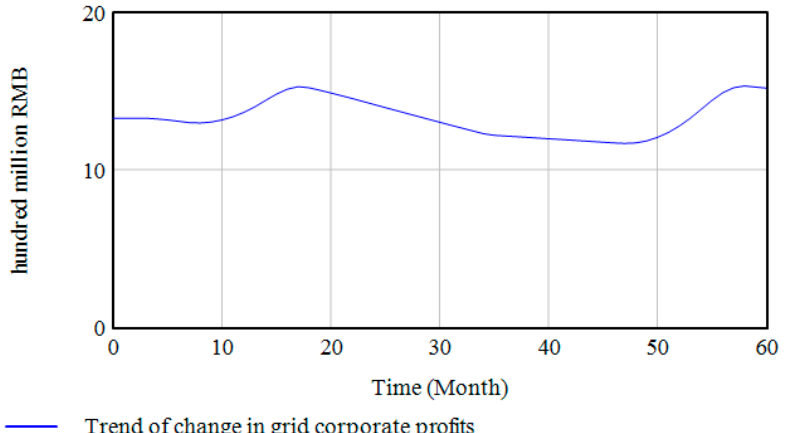
Figure 12. Trend of change in grid corporate profits.